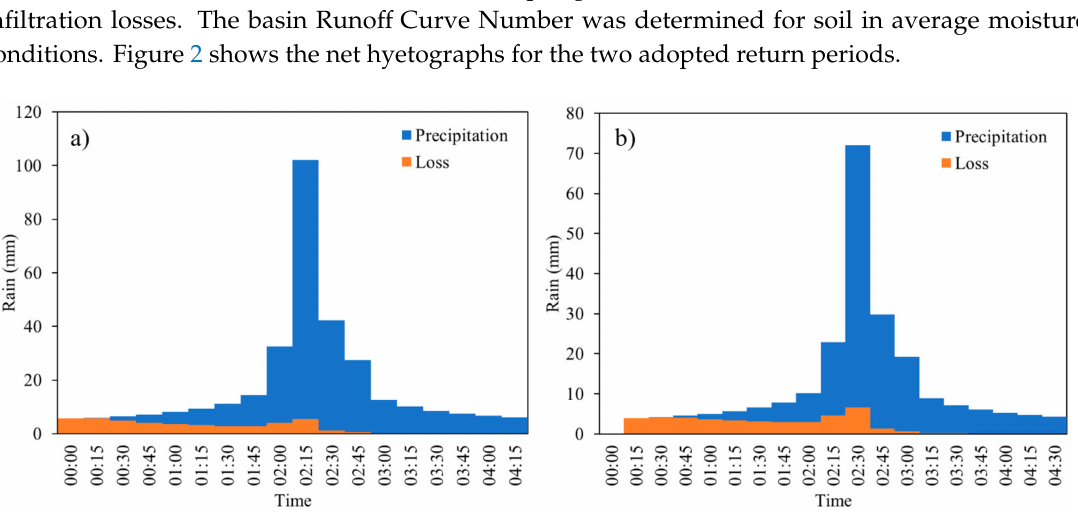
Figure 2. Net hyetographs for 30 years ( a ) and 200 years ( b ),